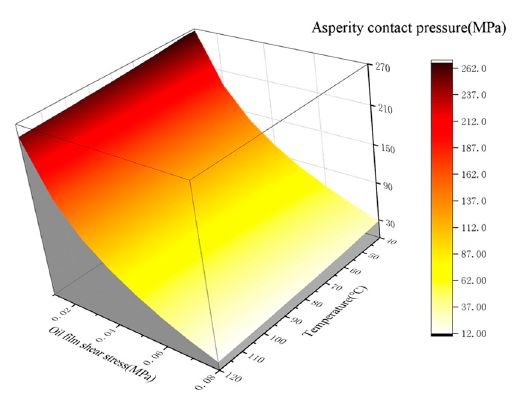
Figure 8. Model curved surface of boundary film strength.